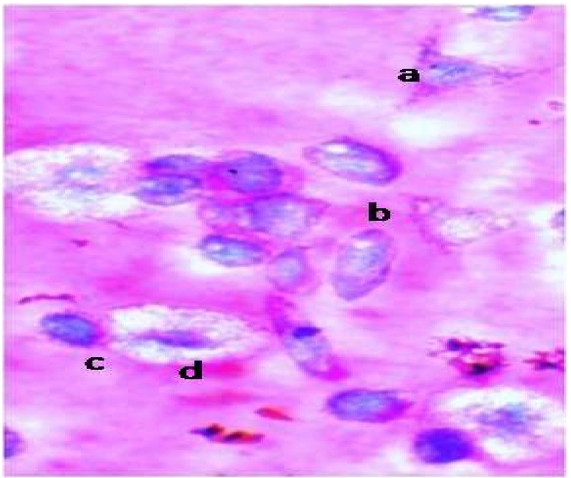
Figure 1. (a, b) Normal plasmatocytes (c) Normal granulocyte (d) Normal spherulocyte.